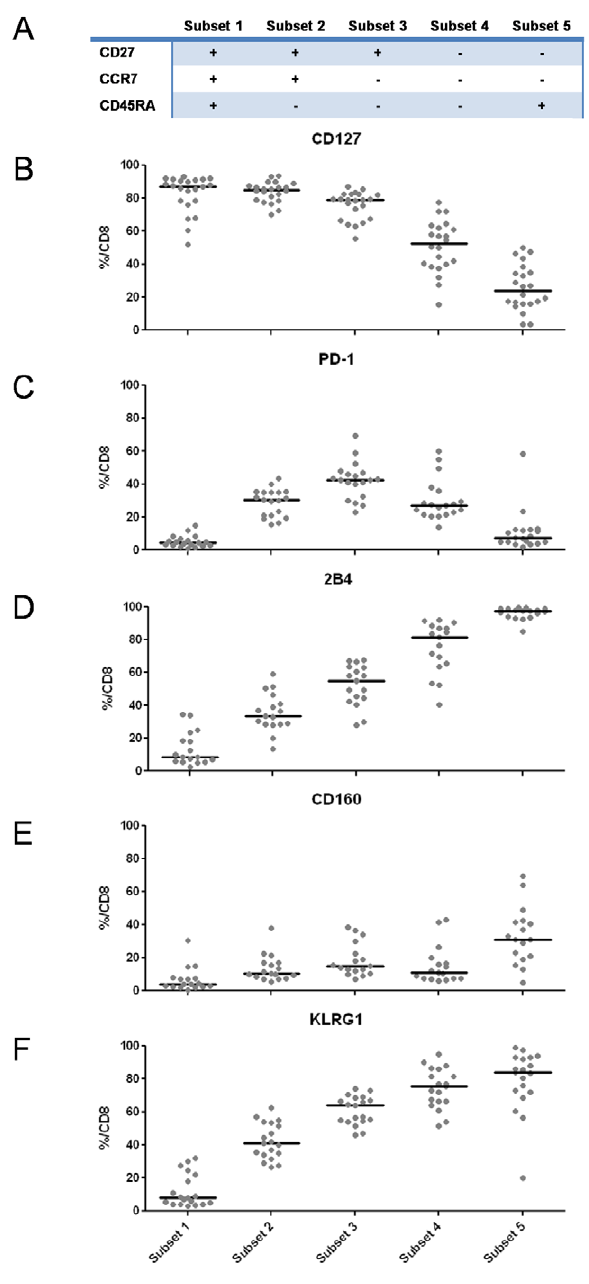
Figure 5. Receptor expression profiles are linked to T cell differentiation. (A) Schematic overview of the differentiation stage of CD8 + T cells assessed by differential CD27, CCR7 and CD45RA expression. (B–F) Expression of CD127 and inhibitory receptors PD-1, 2B4, CD160 and KLRG1 in individual CD8 + T cell differentiation subsets. Each dot represents the frequency of CD127 or inhibitory receptor expression on CD8 + T cells belonging to the given differentiation subset of an individual